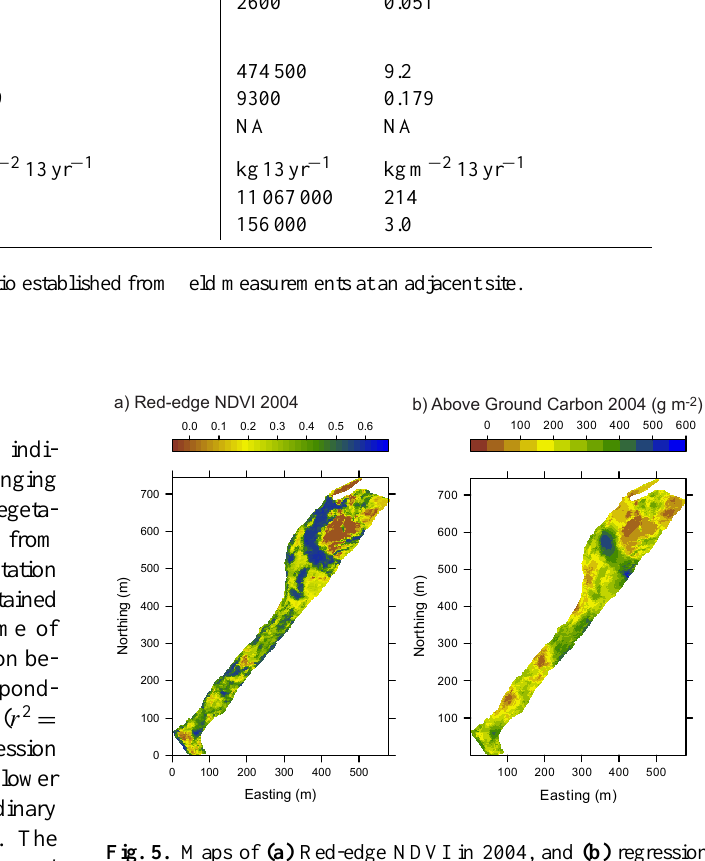
Fig. 5. Maps of (a) Red-edge NDVI in 2004, and (b) regression kriging map of above-ground carbon in